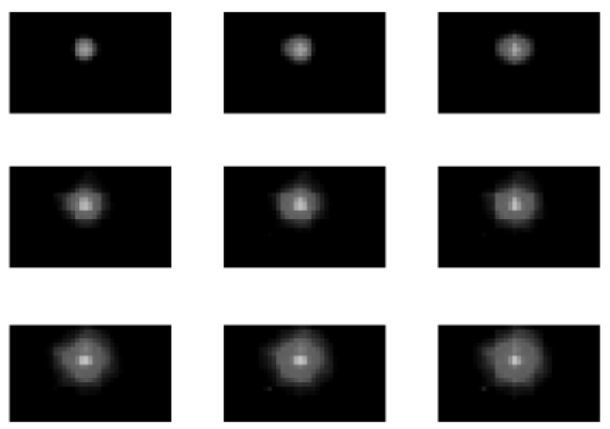
1. Representative samples of images used in the emitter-to-camera distance